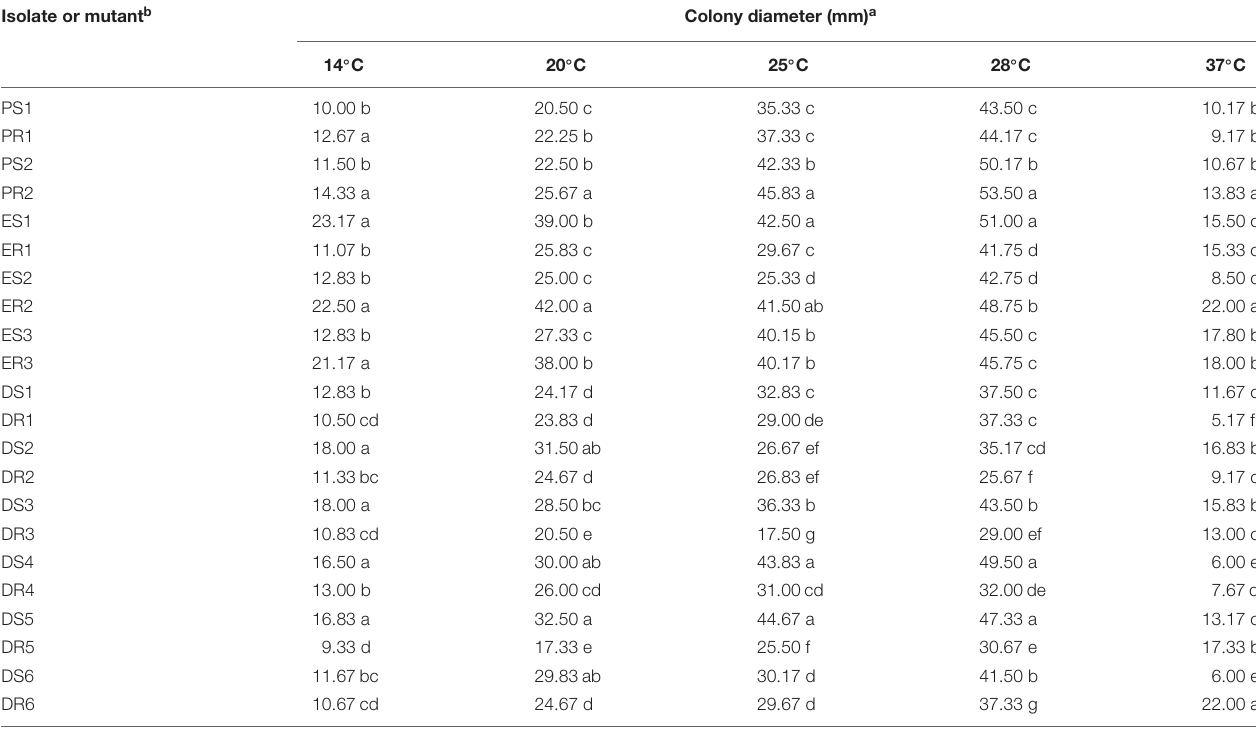
TABLE 2 | Effect of temperature on mycelial growth of DMI-resistant mutants of Colletotrichum truncatum and their wild-type parents on PDA. Isolate or mutant